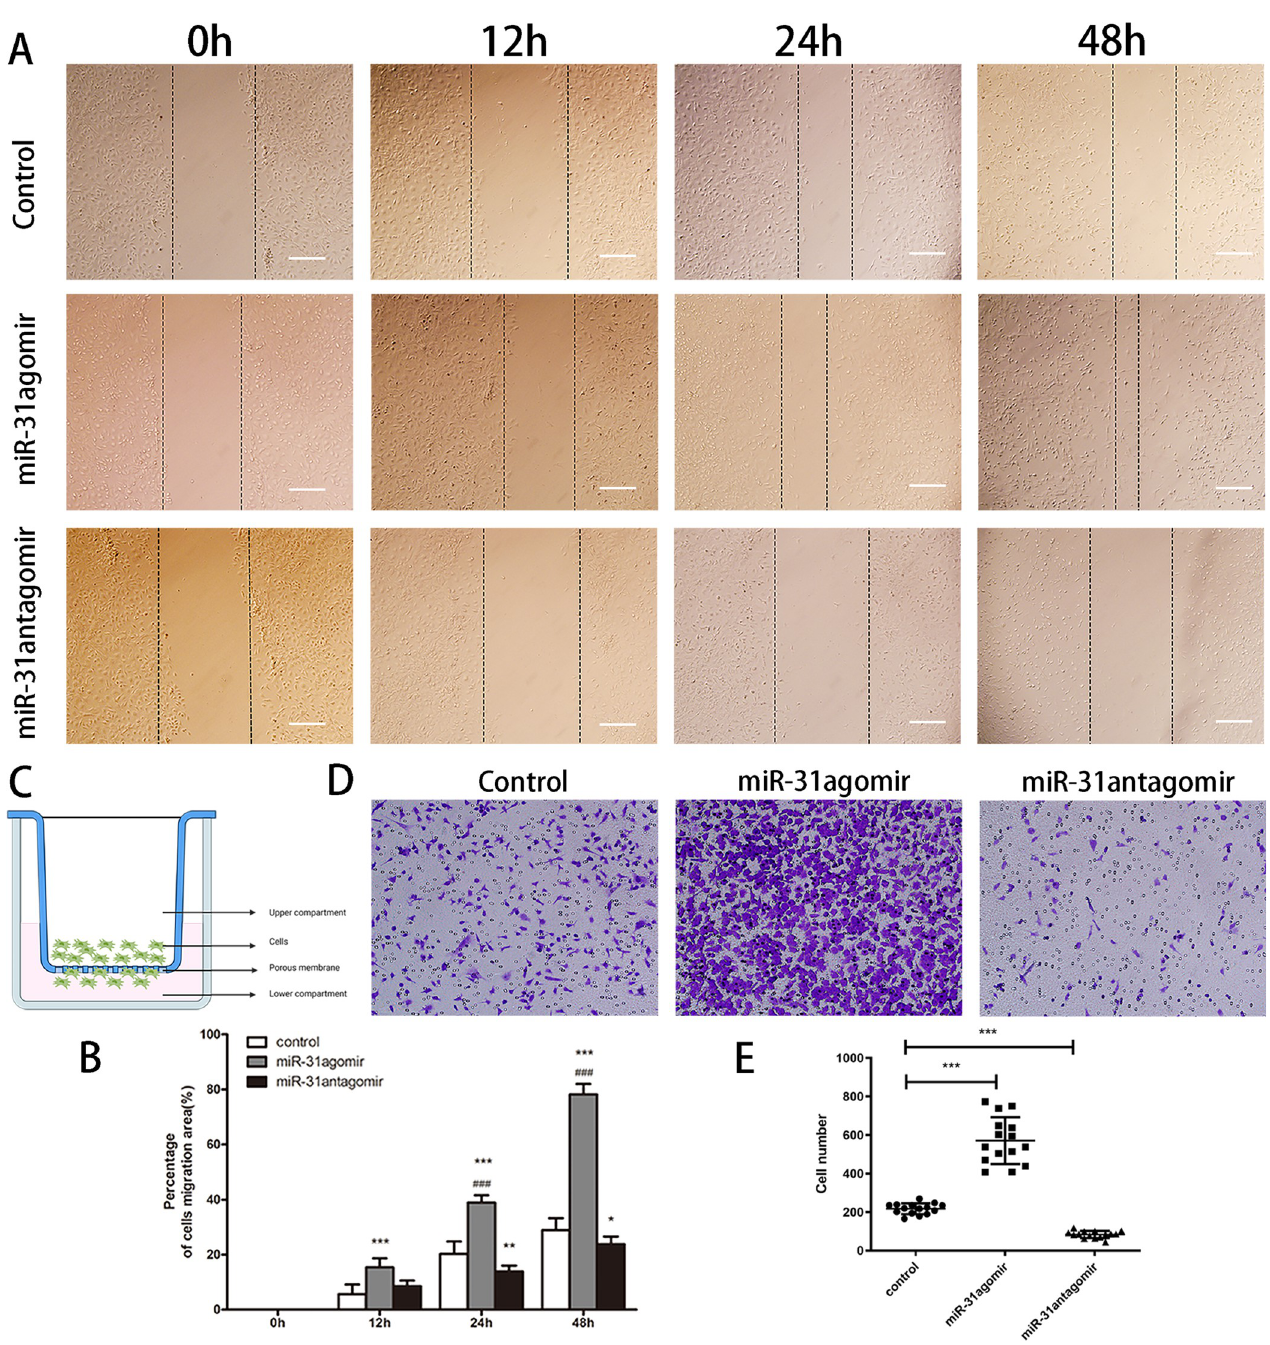
Fig 4. Analysis of the effect of miR-31 on the migration of BMSCs. A The promoted effect of miR-31 on the horizontal migration of BMSCs tested by bidirectional wound-healing assay at 0, 12, 24 and 48 hours. Scar bar: 100 μ m. B Percentage cell migration area result statistics for control, miR-31 agomir and miR-31 antagomir at 0, 12, 24 and 48 hours. C Schematic diagram of the vertical cell migration tested by Transwell chamber assay. D Cells that passed through the polycarbonate membrane were stained with crystal violet, observed under an inverted phase contrast microscope and counted in 200 × magnification field. Scar bar: 50 μ m. E Statistical results of the number of cells in the lower chamber of the migration value of BMSCs. Dates are presented as mean ± SD (n = 5,15). Statistical analysis: within group compared to control, � P < 0.05, �� P < 0.01, ��� P < 0.001; between groups compared to 12 hours miR-31 agomir, ### P < 0.001.